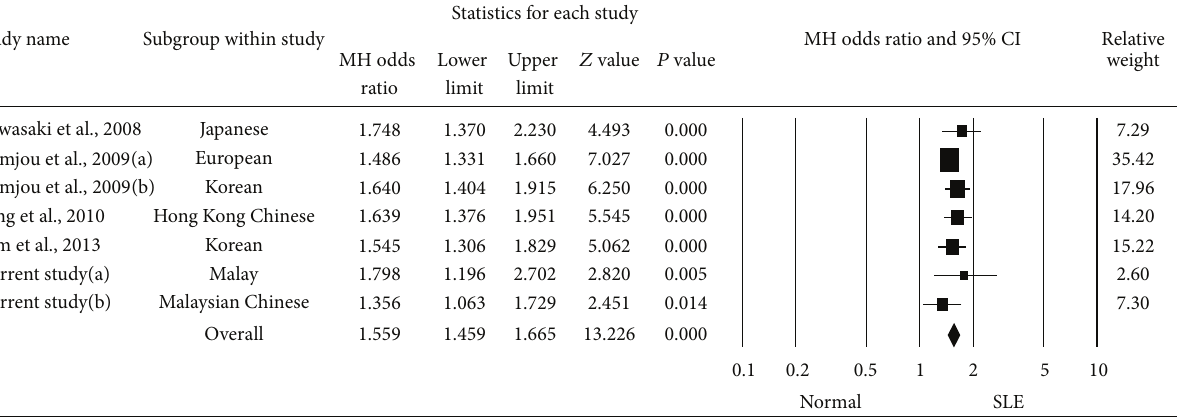
Figure 1: Forest plot of individual and pooled ORs with 95% CI for STAT4 rs10168266 with SLE